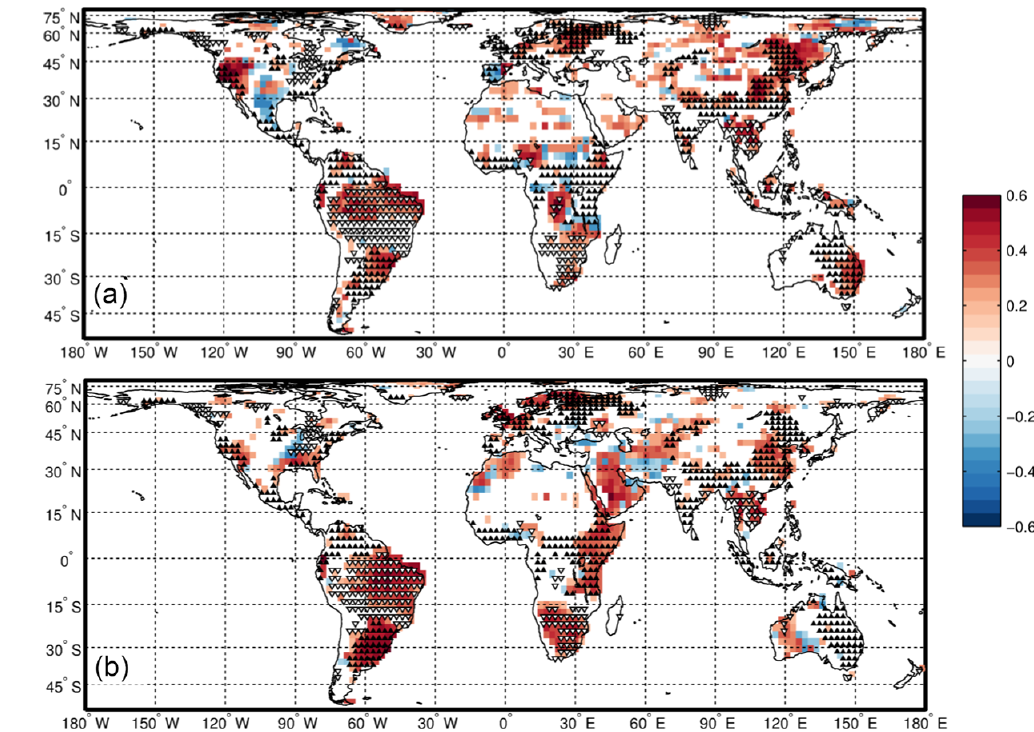
Figure 8. Point-by-point correlation of the second mode of variability in PRE forced by SM with (a) the total fields of PRE forced by ET and (b) the PRE forced by LAI. Data have been filtered using a cutoff low-pass filter at 1year − 1 frequency. Only areas where correlations passed a significance test at the 5% level are shown. Black upward (white downward) triangles denote areas with positive>0.01 (negative < − 0.01) values of the second EOF of the PRE anomalies forced by the SM (Fig.